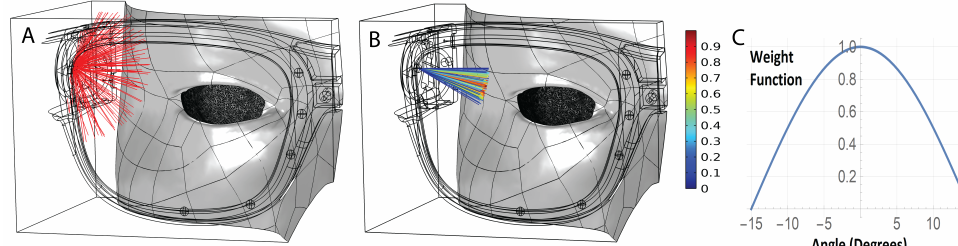
Figure 7. Sensor directionality options. ( A ) Omnidirectional; ( B ) Directional. The color of the ray indicates its intensity; ( C ) Weigh function to mimic the transducer native curve (shown in Figure